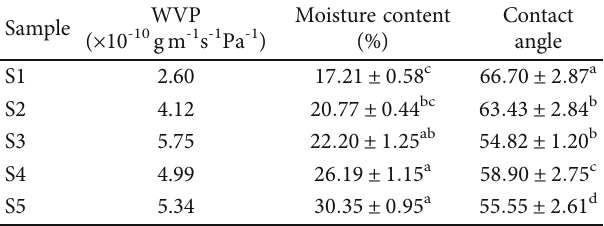
Table 3: Moisture properties of the blend fi lms. WVP Sample ( × 10 -10 gm -1 s -1 Pa -1